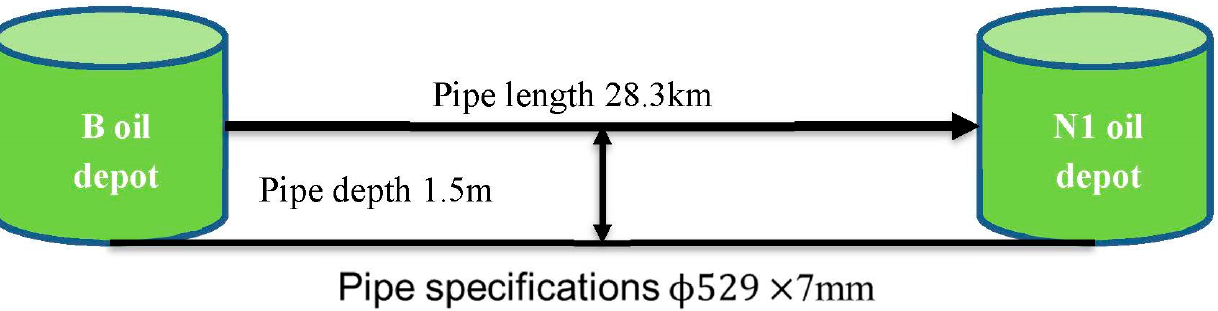
Figure 1. Schematic diagram of the oil pipeline.